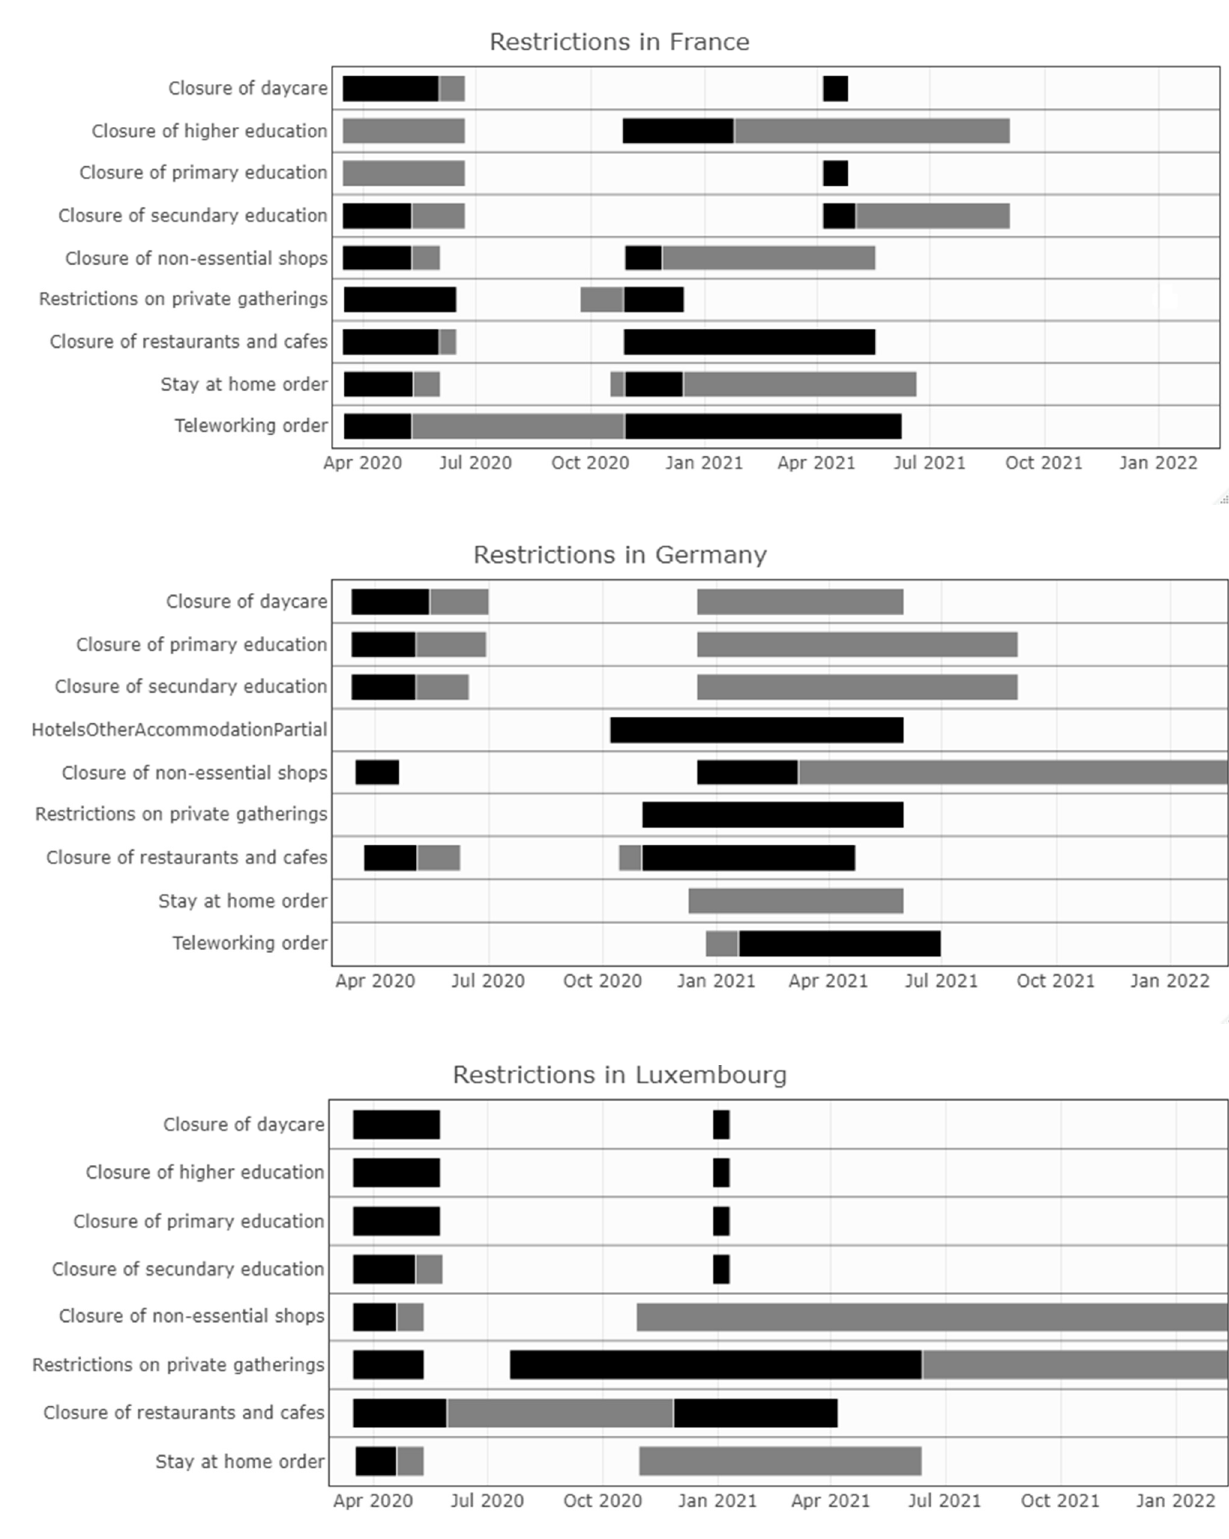
Figure 5. Non-pharmaceutical interventions (NPIs) implemented over time in Belgium, France, The Netherlands, Germany, and Luxembourg, based on the Response Measures Database (RMD) of the European Centre for Disease Prevention and Control (ECDC) and the Joint Research Centre (JRC) of the European Commission, from the start of the COVID-19 pandemic in March 2020 until January 2022. Black indicates full closures/restrictions, while grey indicates partial closures/restrictions.